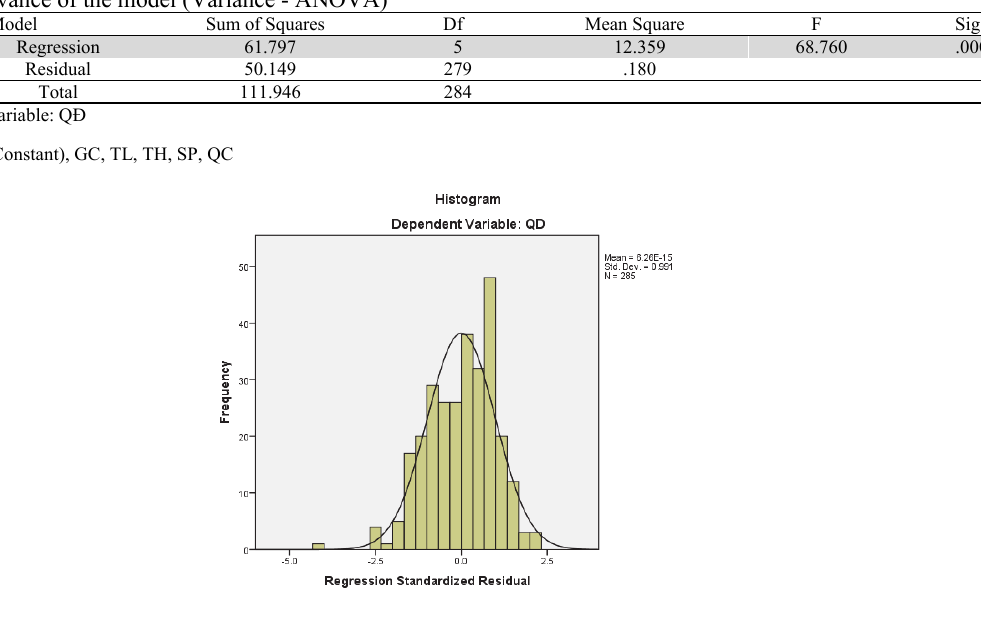
Fig. 2. Scatter graph of standardized